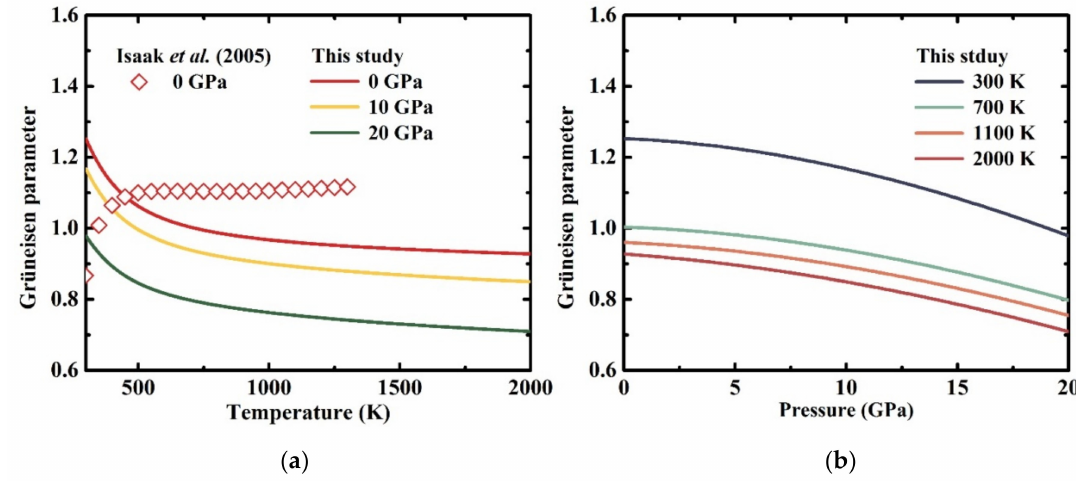
Figure 6. Temperature ( a ) and pressure ( b ) dependences of the Grüneisen parameter of diopside. Solid lines refer to our calculated results. The diamonds correspond to the results from Isaak et al. (2006)